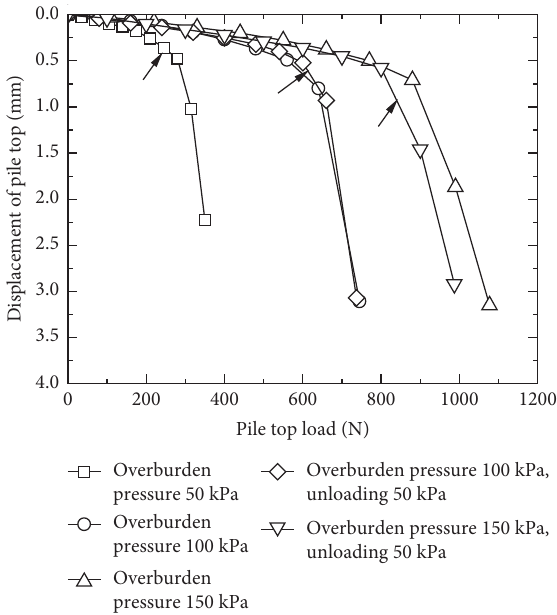
Figure 14: Load-displacement curves for the pile top.